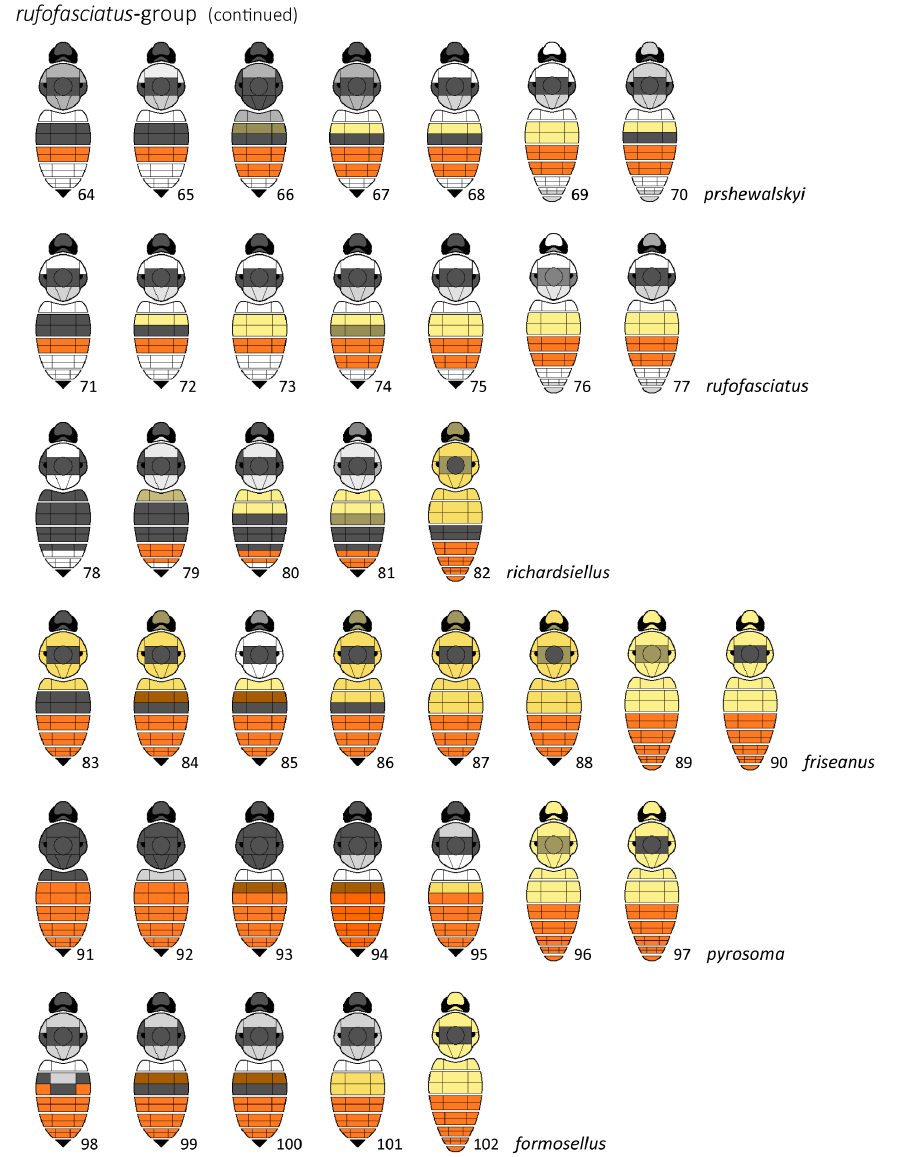
Figs 64–102. Simplified diagrams for the colour patterns of the hair on the dorsum for the species from the integrative analysis. The dorsum is divided into regions, each of which shows only the predominant or most apparent colour for that region using a simplified colour palette, with olive indicating a mixture of black and yellow hair, and grey indicating a mixture of black and white hair. The rufofasciatus